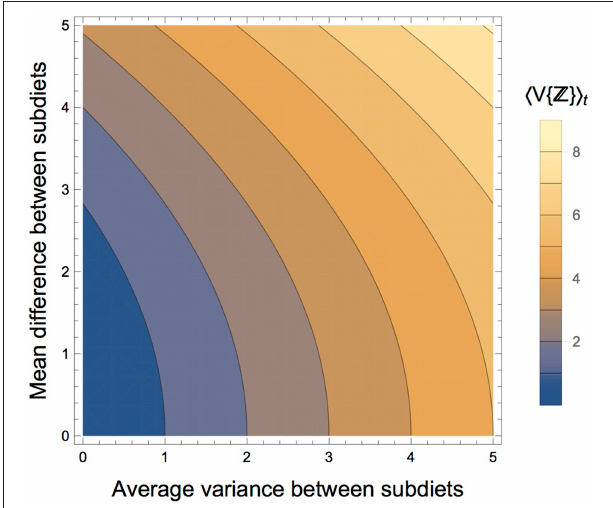
FIGURE 4 | Components of the mixing space that affects the time-averaged variance of the composite diet, h V { Z }i t . As the average variance between the subdiets increases, the time-averaged variance of the composite diet increases. As the difference in the isotopic means of the subdiets increase, the time-averaged variance of the composite diet increases, though at a slower